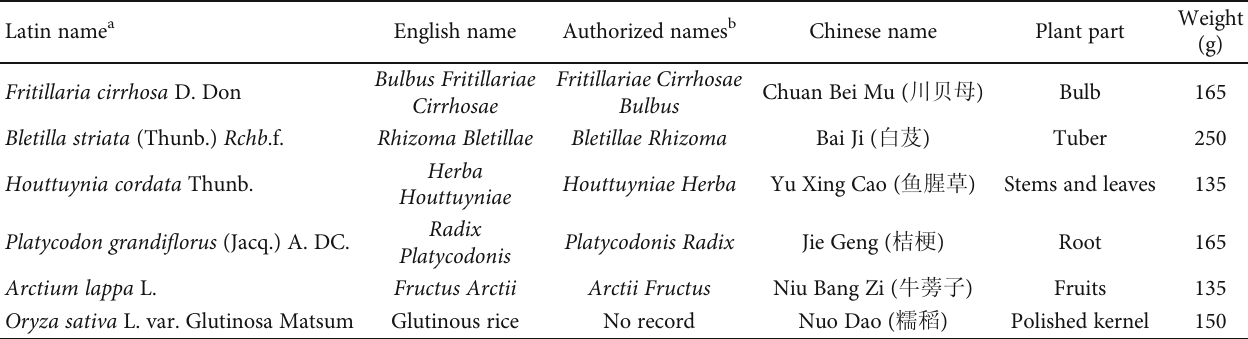
Table 1: The components of